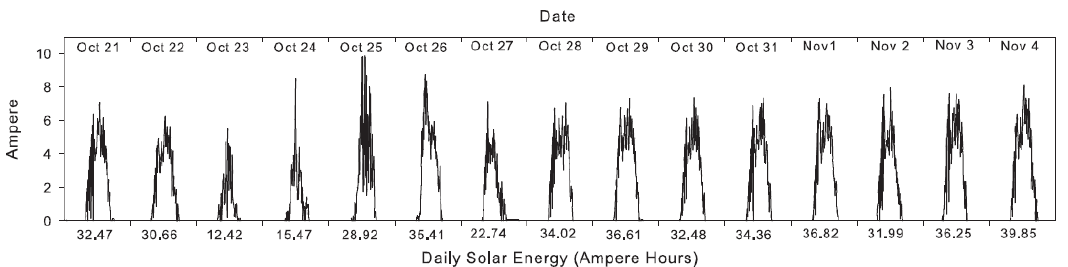
Figure 2. Amount of energy harvested by an energy-harvesting node